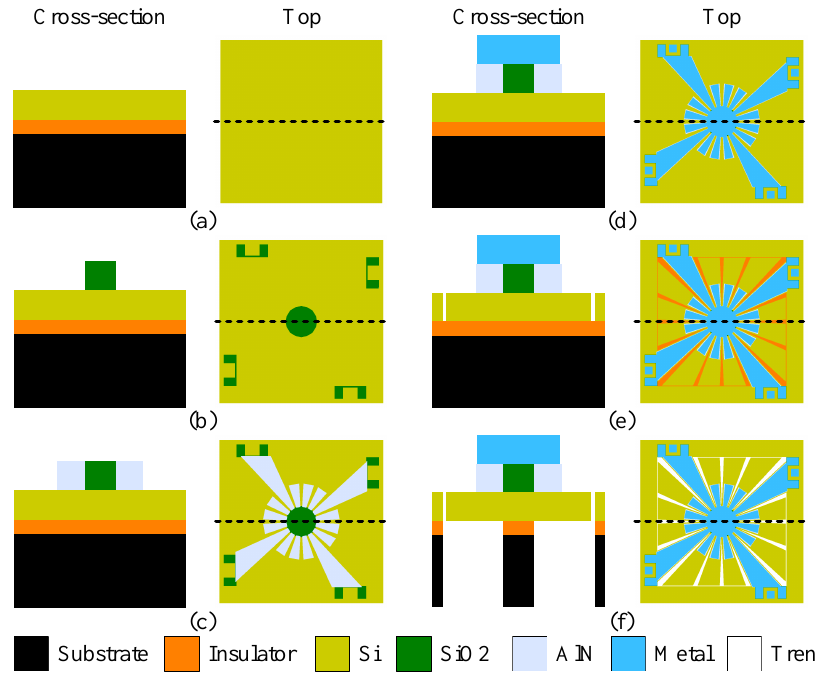
Figure 4. Simplified overview of the PiezoMUMPs’ fabrication process flow, applied to the fabrication of Variant 2 of the Squared Daisy.